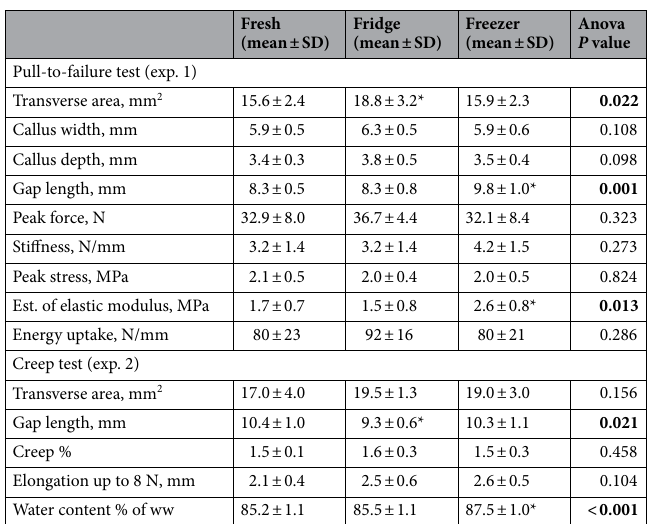
Table 1. Mechanical results from fresh samples and samples stored in the fridge or freezer. Pull-to-failure test was analyzed in experiment 1 and creep test was analyzed in experiment 2 (n = 10). Est. of elastic modulus means estimation of elastic modulus. SD = standard deviation. Bold means significant a difference. *Significantly different compared to fresh samples. % of ww indicates percentage of wet